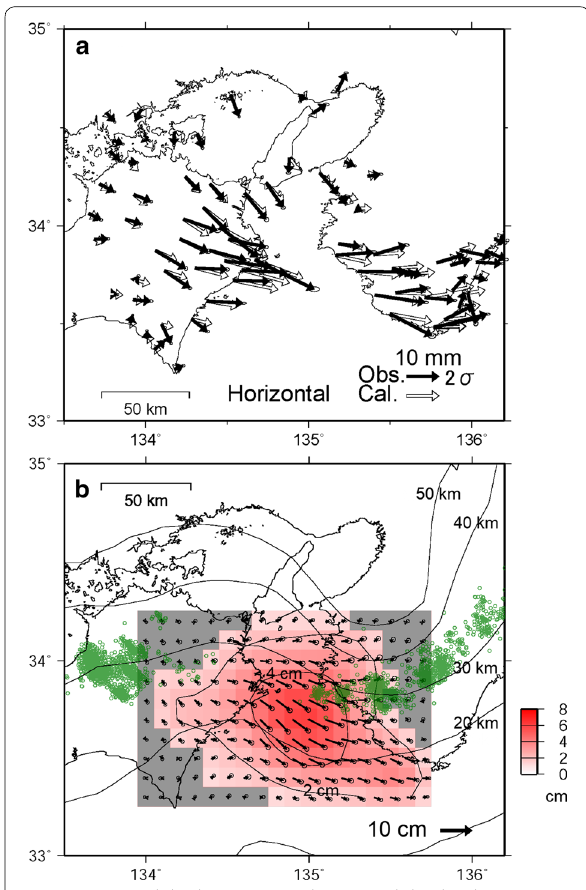
Fig. 8 Horizontal displacements and estimated slip distribution in eastern Shikoku and Kii Channel for the period January 2014 to January 2017. a Horizontal displacements used for estimating slip. b Estimated slip distribution. Green circles indicate epicenters of deep low-frequency earthquakes from January 2014 to January 2017. Sym- bols are the same as in Fig.